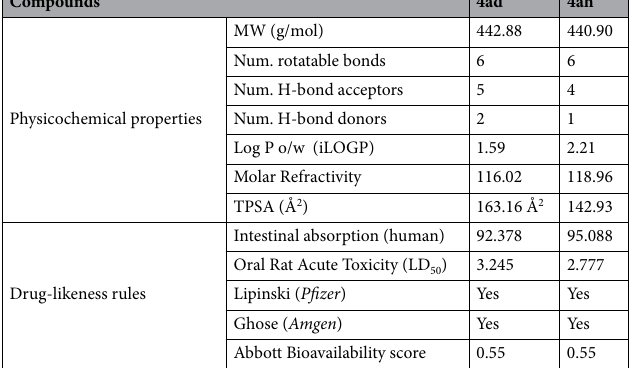
Table 4. In silico prediction of pharmacokinetic properties of the synthesized